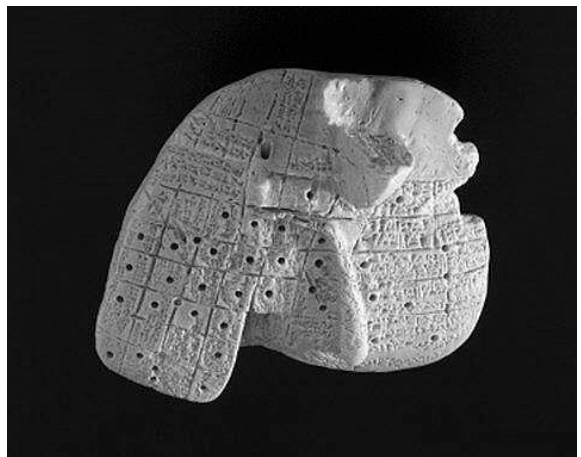
Figura 3 . Modelo em argila do fígado de um carneiro